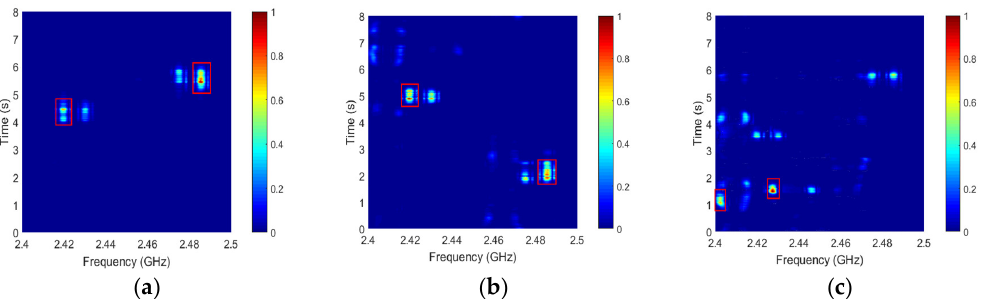
Figure 14. The results for the improved cross-correlation method for two UAVs outdoors at distances of ( a ) 500 m, ( b ) 1500 m, and ( c ) 2500 m.